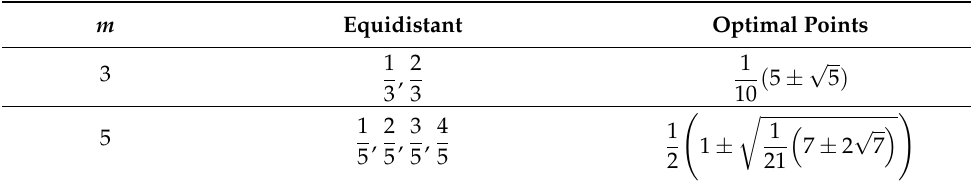
Table 2. Intra-step points used in numerical experimentation.